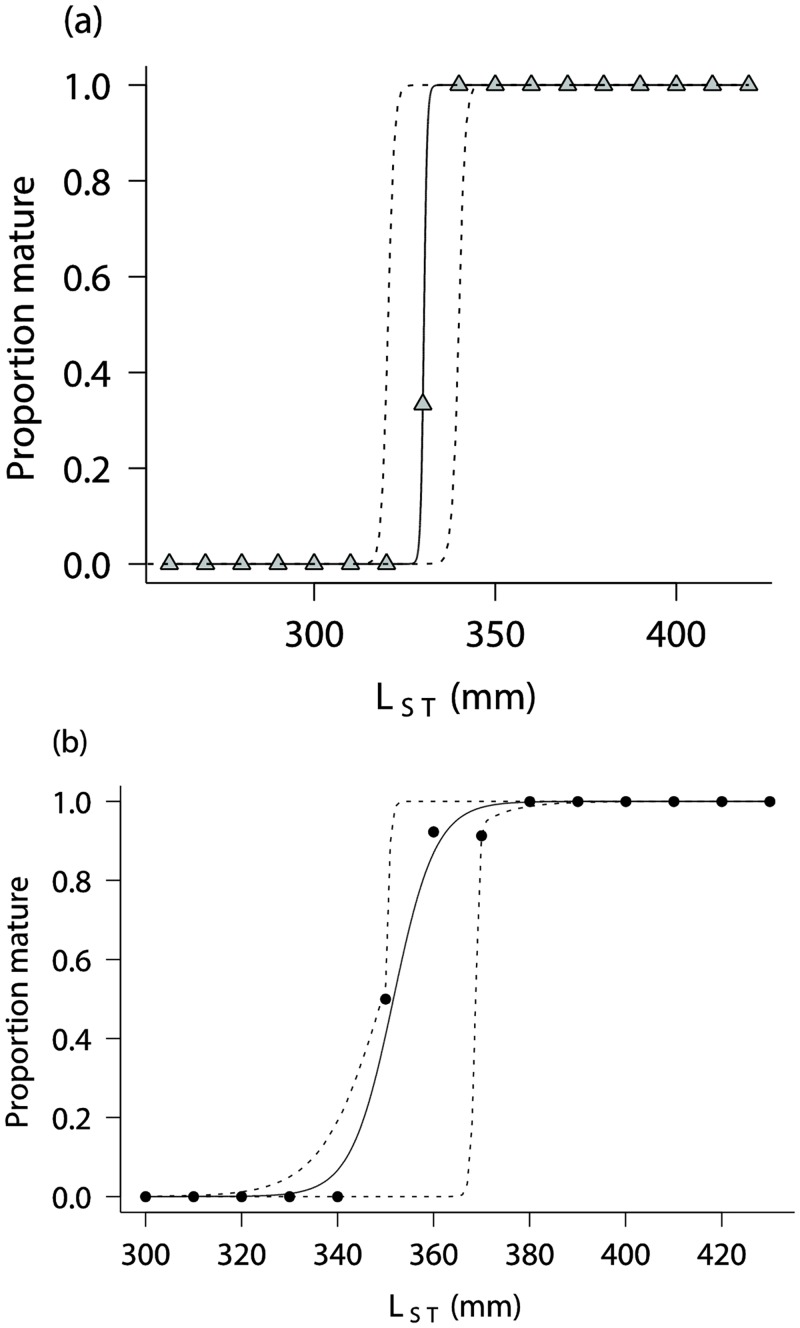
Length at maturity ogives for Asymbolus pallidus.(a) males and (b) females. Dashed lines are 95% confidence intervals.